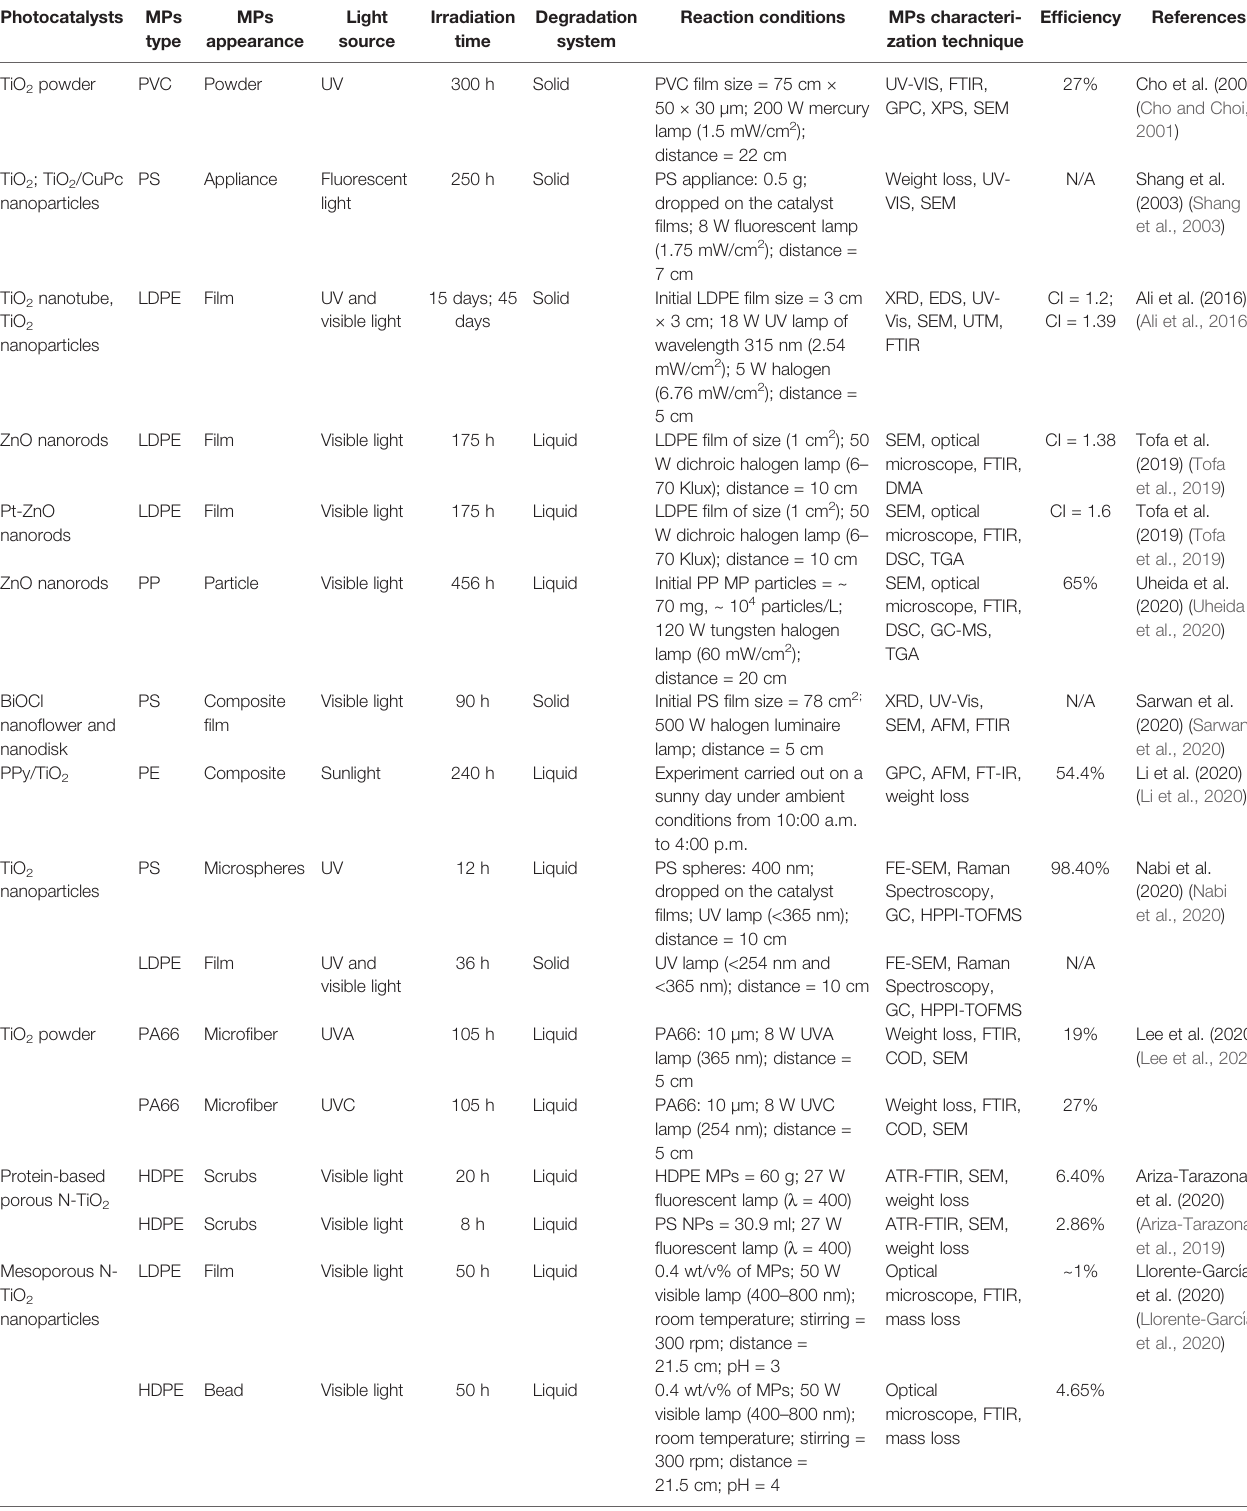
TABLE 1 | Main studies of MPs ’